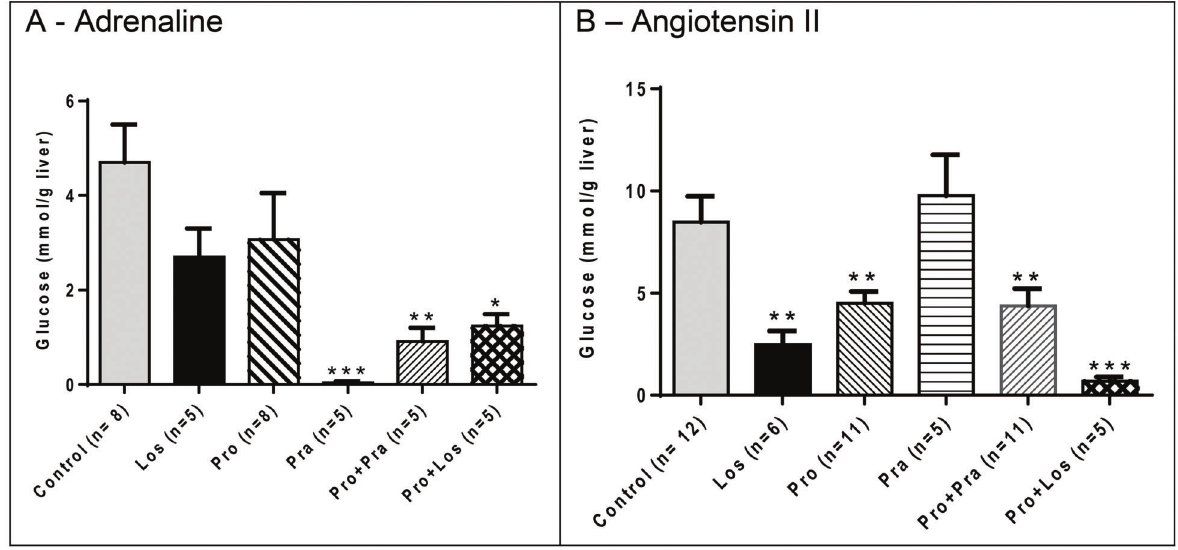
Figure 2 . Glucose release from the perfused liver following in bolus injection of 40 nmol adrenaline (Adr) or 2 nmol angiotensin II (AII). Glucose release was calculated from the graphs ‘‘ glucose output x perfusion time ’’ , after Adr or AII injection, in the presence or absence of antagonists. Los: losartan; Pra: prazosin; Pro: propranolol. Data are reported as means ± SE. *P o 0.05, **P o 0.01, ***P o 0.001: compared with the control group; Adr: Pro vs Pra (*); AII: Los vs Pra (**); Pro vs Pra (**); Pra vs Pro + Pra (*); Pra vs Pro + Los (***) (ANOVA followed by Newman